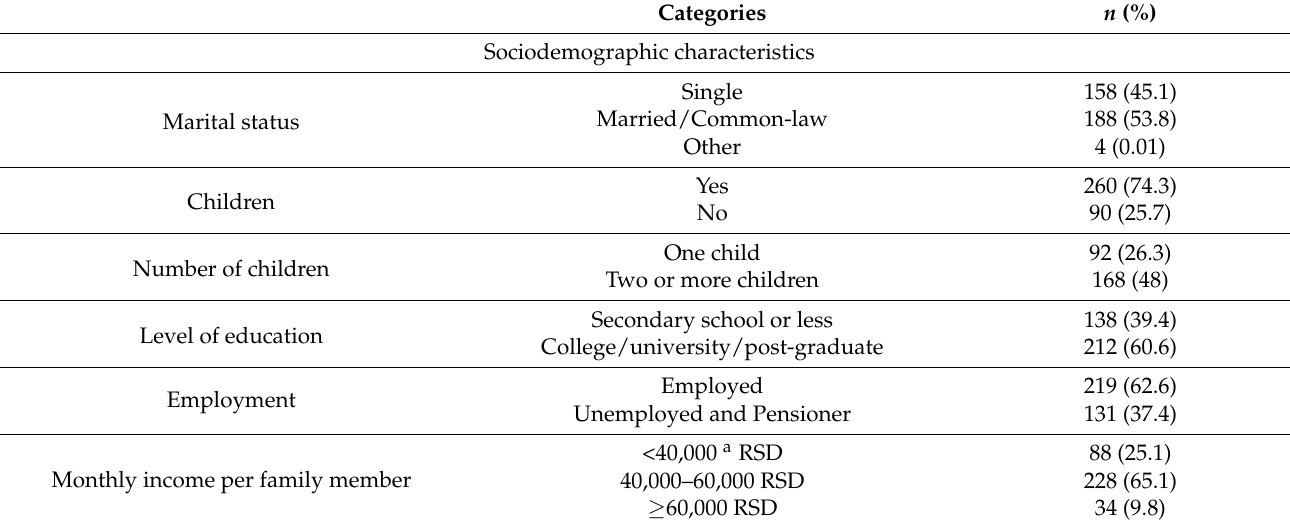
Table 1. Sociodemographic characteristics, health-related characteristics, health behaviors, access to health-related information, and empowerment-related indicators of the